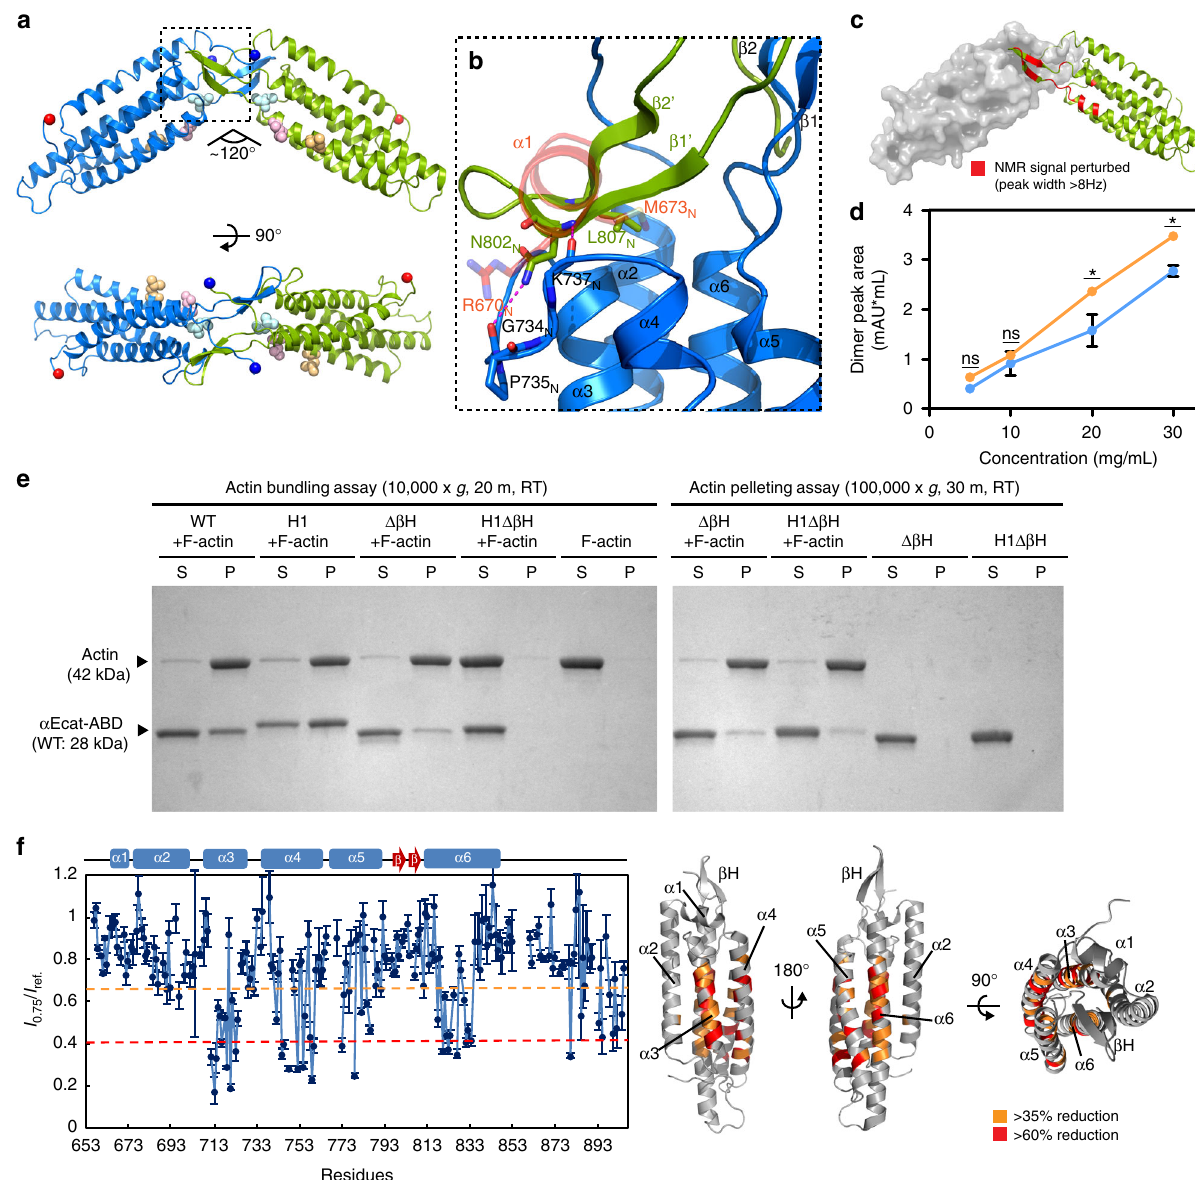
Fig. 2 Crystal structure of α Ncat-ABD-H1 reveals a novel ABD dimer interface. a Crystal structure of the α Ncat-ABD-H1 dimer in form A (two protomers shown as blue and green). The N and C termini of ABD are indicated by blue and red spheres, respectively. Three actin-binding site residues, L785 N , I792 N and V796 N , are shown as light blue, pink and orange spheres. b A close-up view of the ABD dimer interface. The dashed-line box in a is rotated by ~90° CCW. The β H motif from one protomer covers the hydrophobic patch exposed by α 1-helix unfolding in the adjacent protomer (the α 1-helix of α Ncat-ABD- WT is shown in red). c Concentration-dependent CSPs of α Ncat-ABD-H1 are localized to the β H residues. Residues with CSP greater than 8 Hz are indicated on the α Ncat-ABD-H1 structure in red. d SEC-MALS analysis of α Ecat-ABD. The integrated dimer peak area was plotted against the α Ecat-ABD concentration for α Ecat-ABD-WT (blue) and α Ecat-ABD-H1 (orange). Data are presented as mean ± SEM ( N = 3). Signi fi cance by ANOVA: * P < 0.05. e In vitro actin cosedimentation assays of α Ecat-ABD variants, WT, H1, Δβ H, and H1 Δβ H. Actin bundling was analyzed by sedimentation at low RCF (10,000× g ). The F-actin-bound ABD was sedimented at high RCF (100,000× g ). f TCS experiments with unlabeled F-actin and 15 N/ 2 H-labeled α Ncat-ABD- WT. Plots of the reduction ratios of the backbone amide signal intensities observed with and without presaturation. Residues with >60% and >35% signal reduction are indicated on the α Ncat-ABD-WT structure (right). The affected residues are mostly located in the last four α -helices ( α 3- α